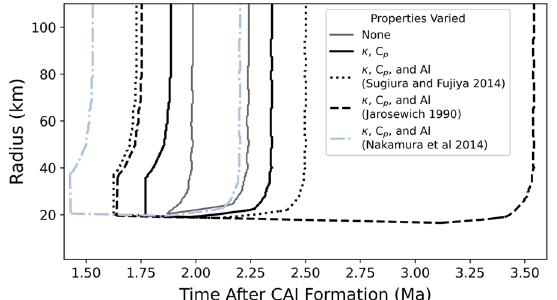
Fig. 3 Effects of varying multiple material properties. The range of possible radius and formation time values for Itokawa’s parent body taking into account uncertainty in conductivity, heat capacity, and aluminum abundance. The properties are varied by the ranges of multiplicative factors given in Table 1. The variation of heat capacity and aluminum abundance lead to significantly larger ranges of possible formation times, with notably smaller minimum radius values, than when no variation or uncertainty in these parameters is